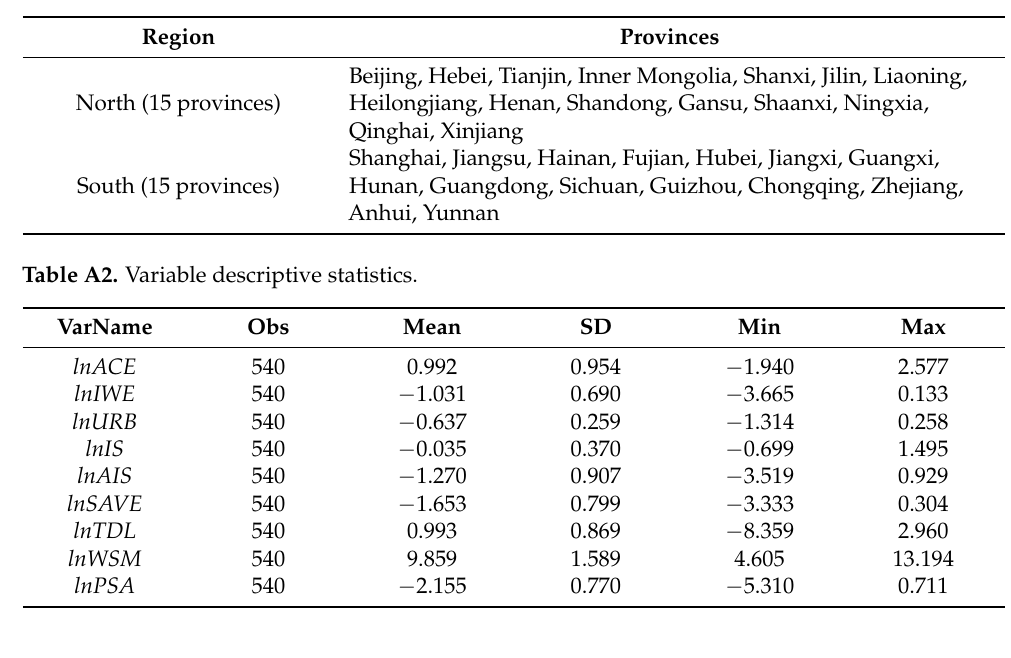
Table A1. The specific provinces across different regions.